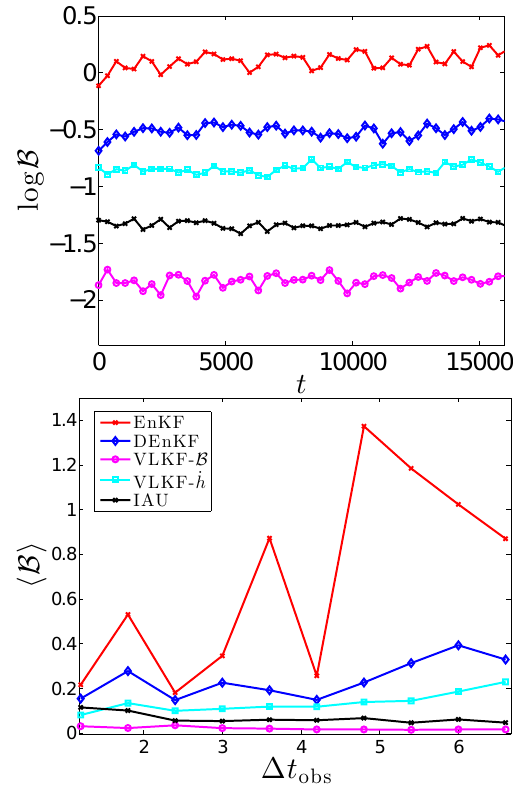
Fig. 4. Top panel: imbalance B of the analysis as a function of anal- ysis cycles for 1t obs =5.5h in a log plot. In order of increasing val- ues of B are VLKF- B (magenta open circles), IAU (black crosses) VLKF- ˙ h (cyan squares), DEnKF (blue diamonds) and EnKF (red crosses). Bottom panel: temporally averaged imbalance h B i of the analysis as a function of the observation interval 1t obs